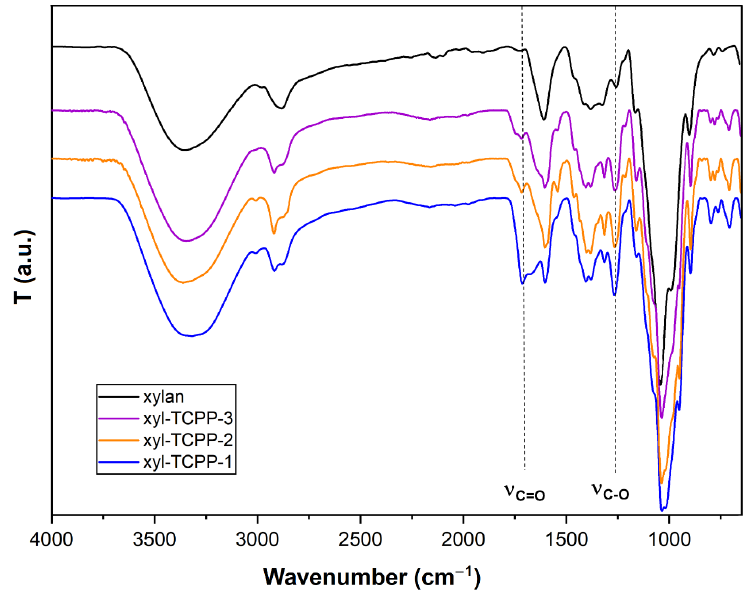
Figure 3. FTIR spectra of native xylan, xyl-TCPP1, xyl-TCPP-2, and xyl-TCPP-3.